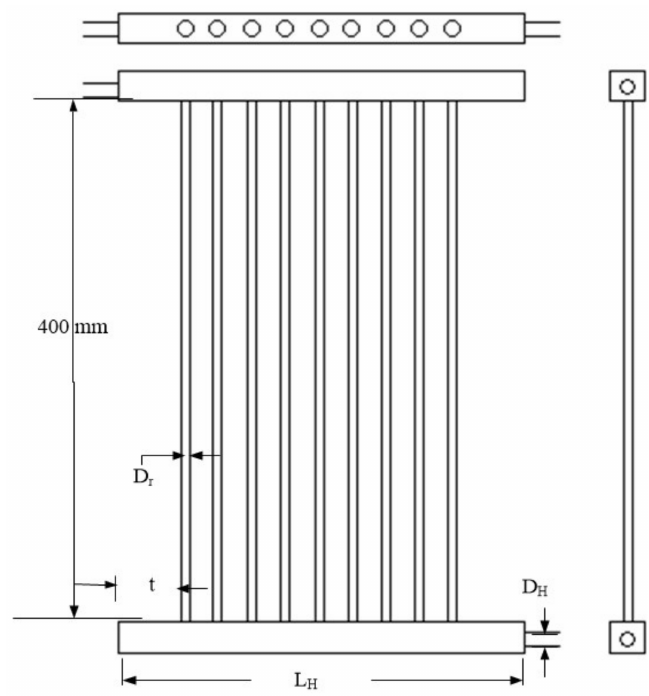
Figure 7. Sketch of the Z type compact heat exchanger